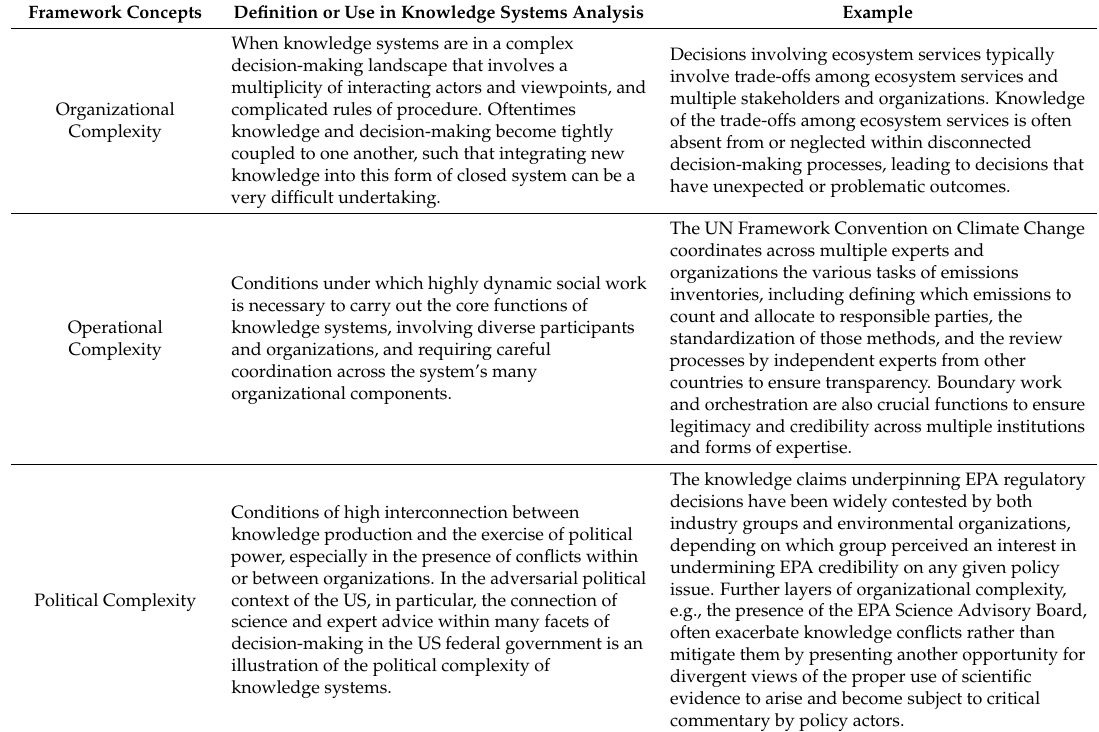
Table 3. Complexities of knowledge